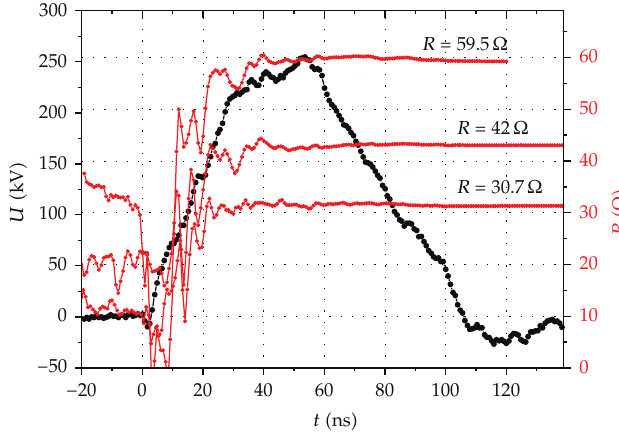
Figure 2: TEU-500 accelerator calibration using various load